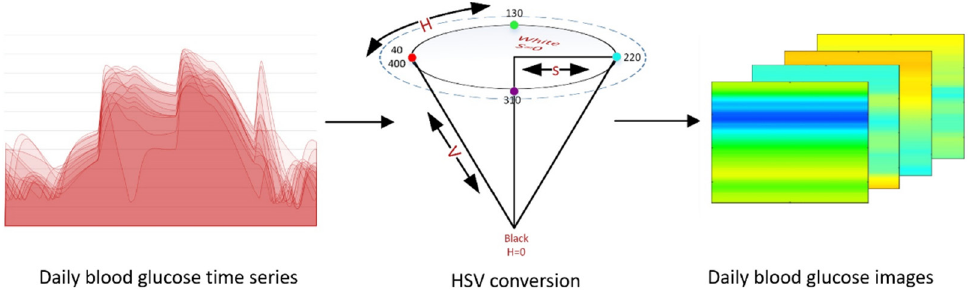
Figure 5. Numerical values to image translation using HSV color map: H stands for hue, S stands for saturation, V stands for value.